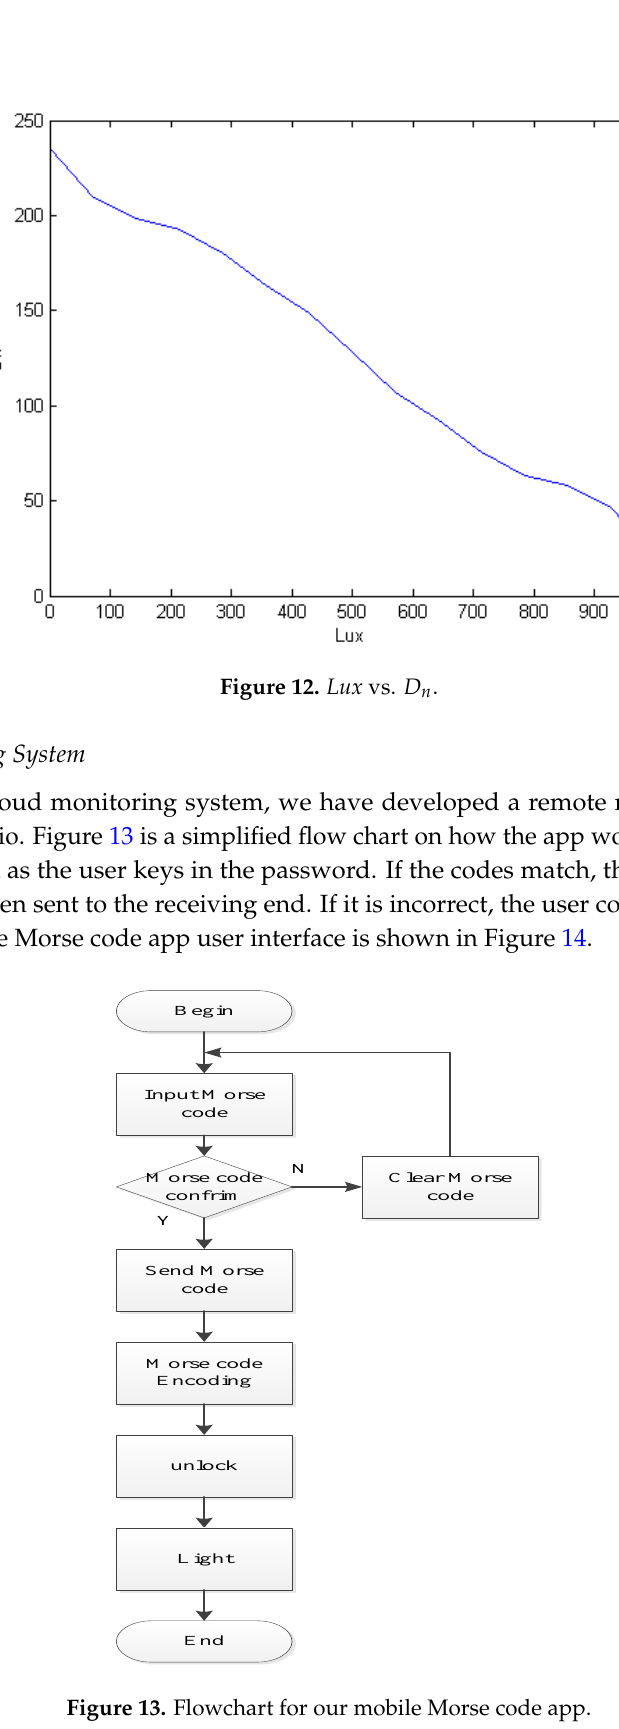
Figure 13. Flowchart for our mobile Morse code app.